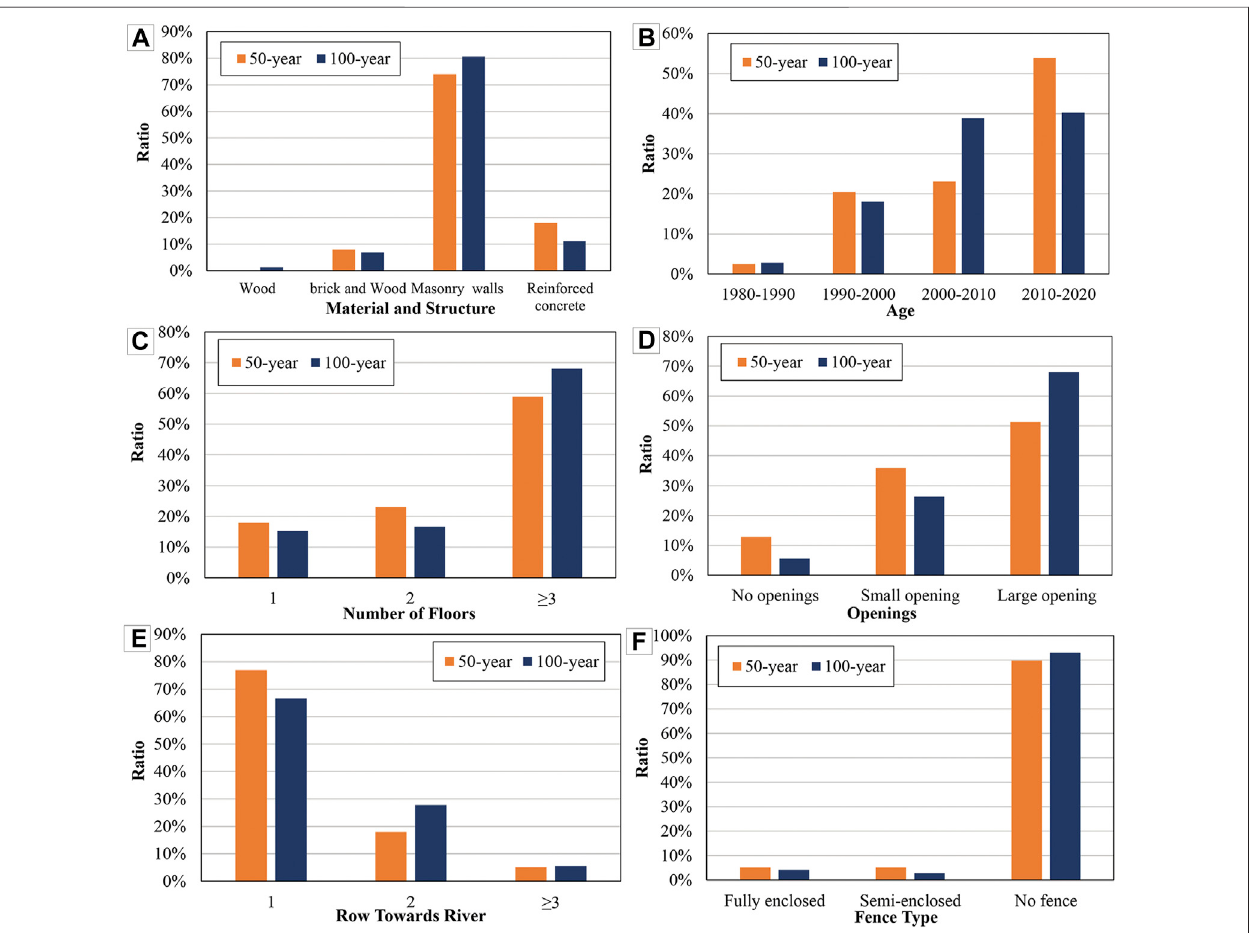
FIGURE 10 | Frequency distribution of vulnerability indicators of exposed buildings (A) material structure type (B) age, (C) number of fl oors (D) openings, (E) rows towards river, and (F) fence type.